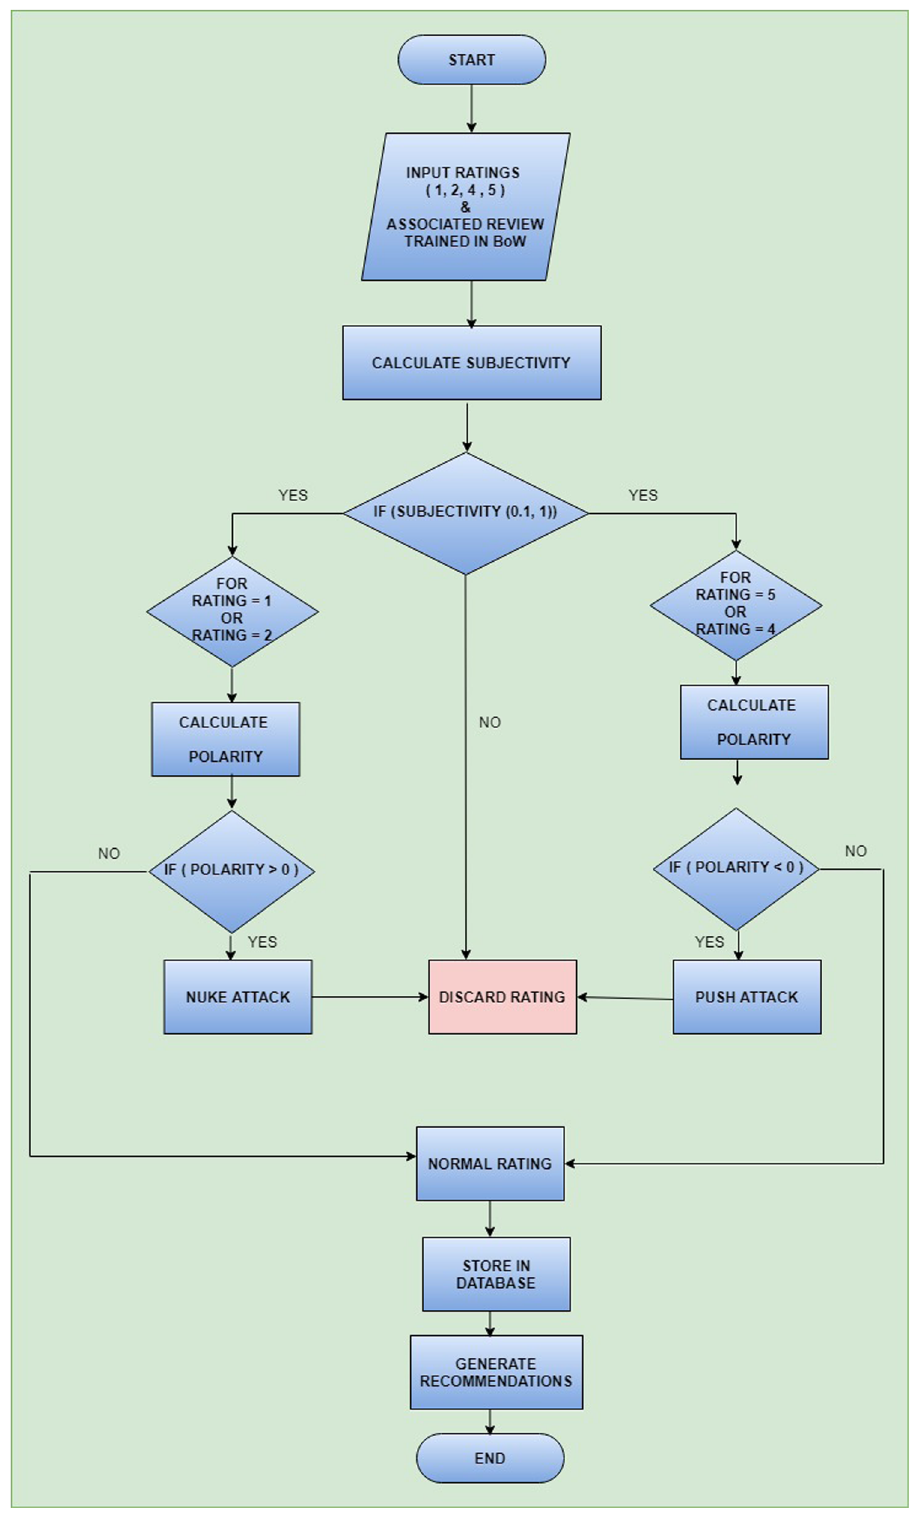
Figure 1: Flowchart to detect PRs and NRs in CFRS using opinion